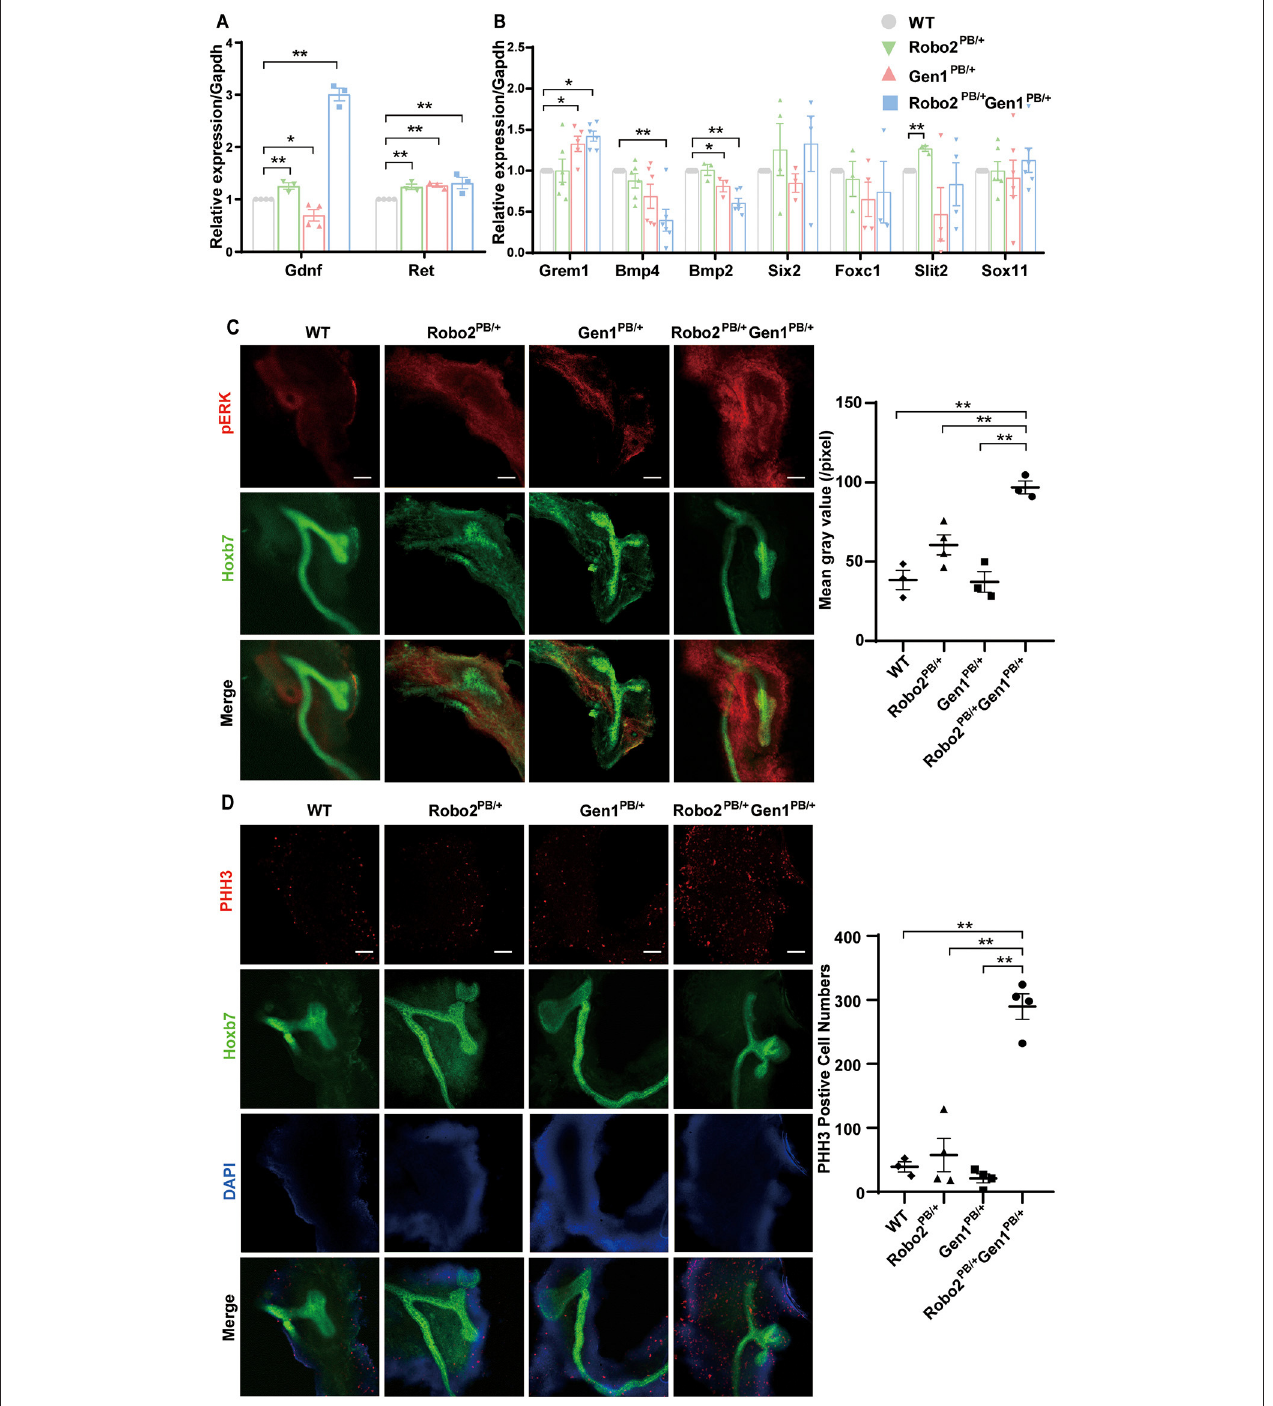
FIGURE 4 | GDNF/RET signaling is increased in the Robo2 PB / + Gen1 PB / + mutants during metanephric development. (A) Changes in Gdnf and Ret expression in kidneys from the E11.5 WT, Robo2 PB / + , Gen1 PB / + and Robo2 PB / + Gen1 PB / + mice, N = 3. (B) Changes in the expression of key genes involved in metanephric development at E11.5, N = 3. (C) Immunofluorescence staining with antibodies against pERK in the kidneys of the WT, Robo2 PB / + , Gen1 PB / + , Robo2 PB / + Gen1 PB / + mice at E11.5. N = 3, original magnification × 10. (D) Immunofluorescence staining with antibodies against PHH3 in the kidneys of the WT, Robo2 PB / + , Gen1 PB / + , Robo2 PB / + Gen1 PB / + mice at E11.5. N = 4, original magnification × 10. Scale bars represent 100 µ m in (C,D) . * P < 0.05; ** P < 0.001.